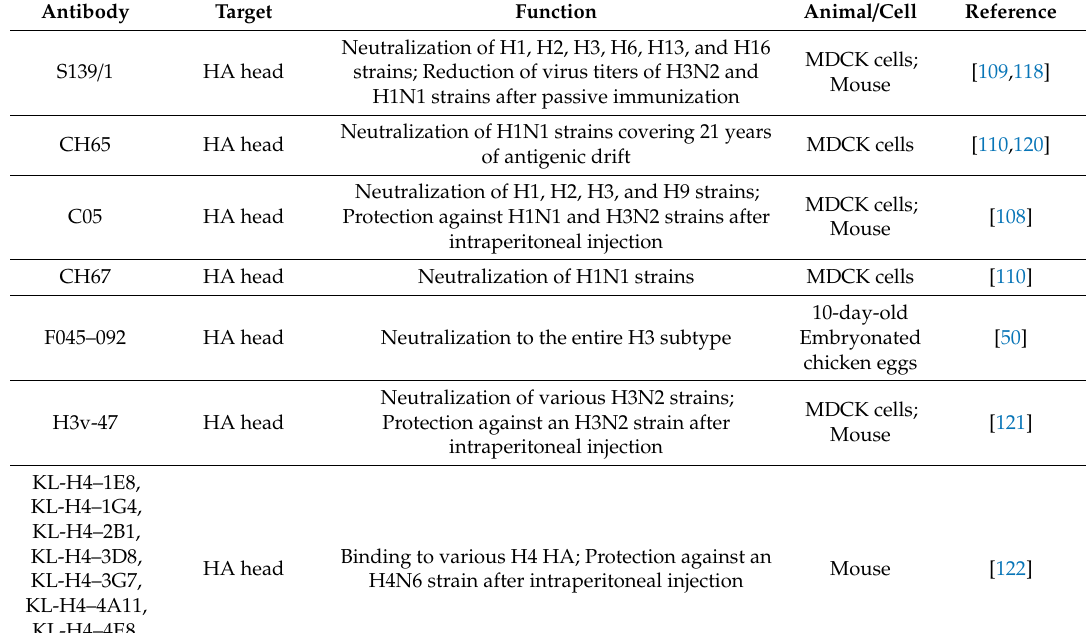
Table 1. The summary of anti-hemagglutinin (HA)